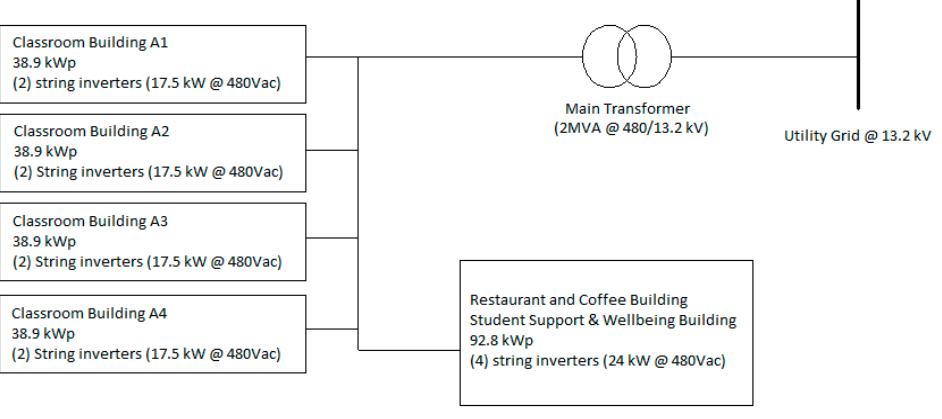
Figure 6. Educational building and canteen—Stage 2.